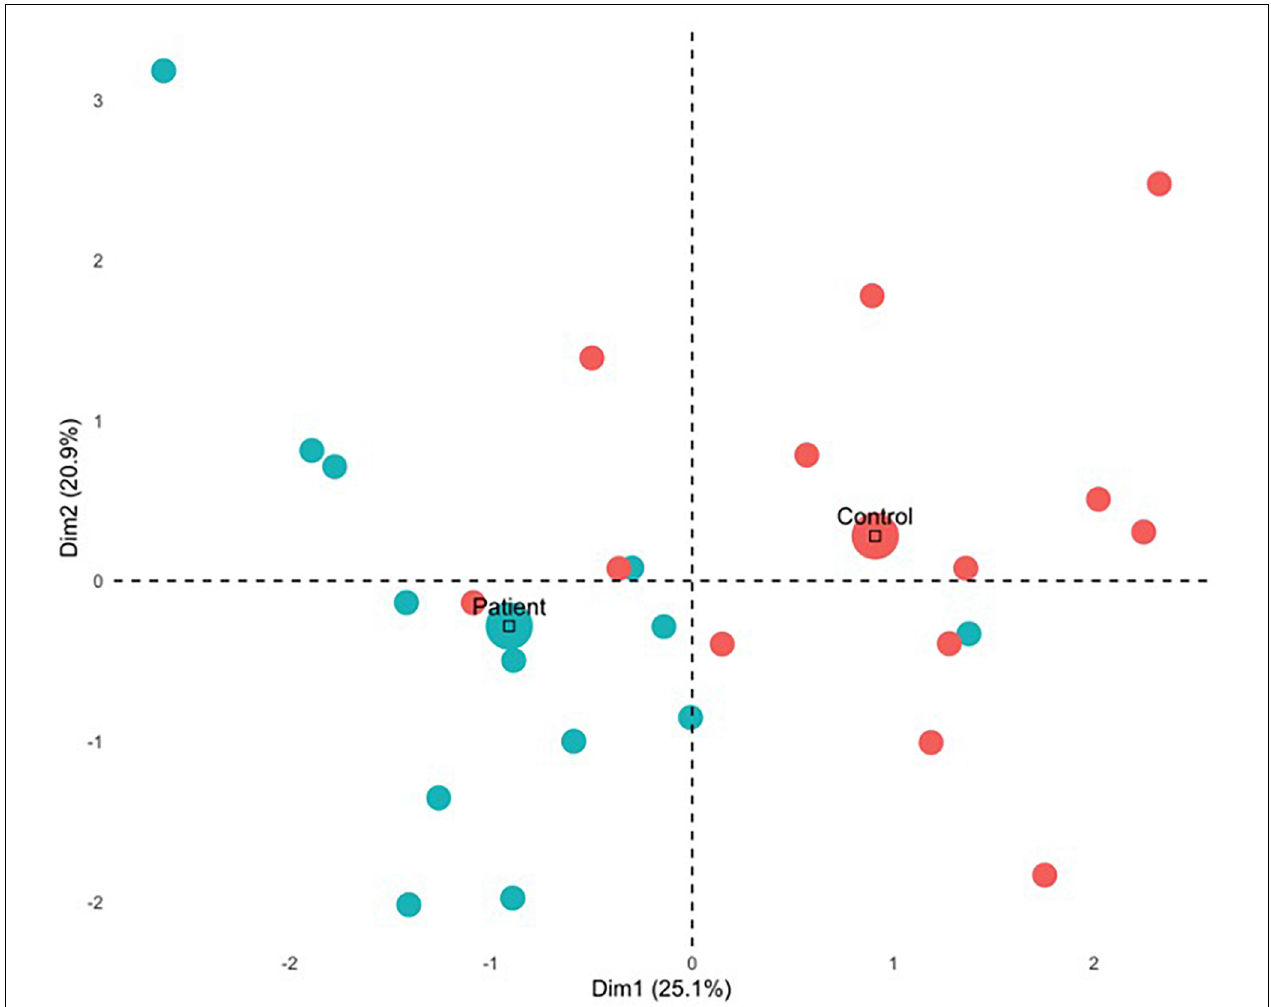
FIGURE 5 | MFA individual contributions. Mean contribution for each group is indicated by the large circle. Control and patient participants contributed differently for Dimension 1 and Dimension 2, as they are in orthogonal quadrants wherein patients tended to contribute negatively and control participants tended to contribute